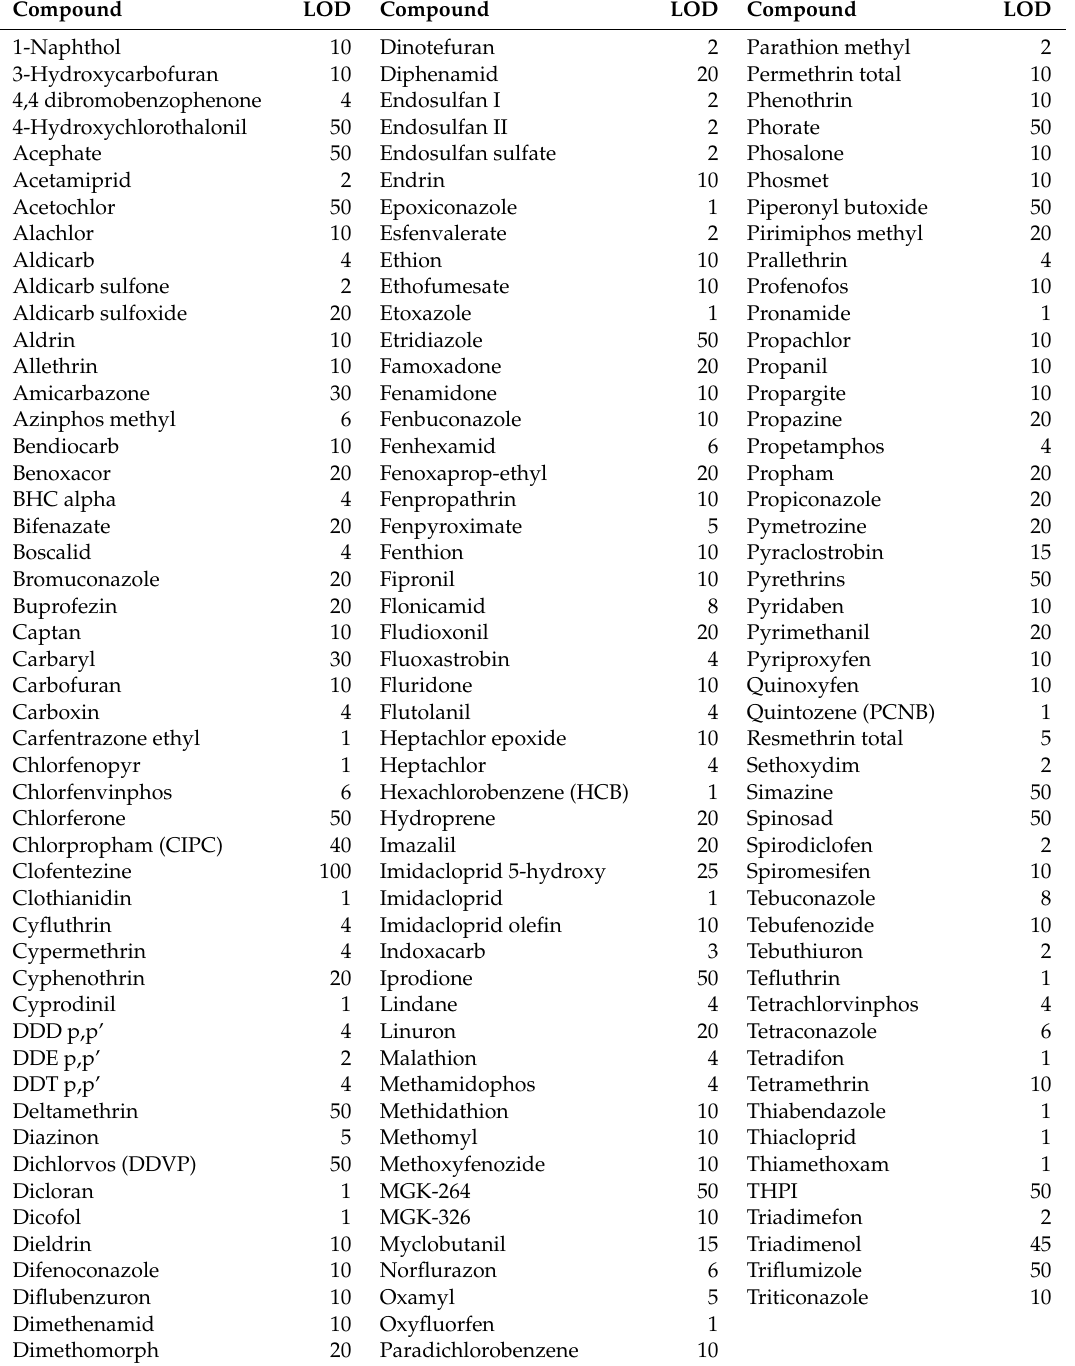
Table 6. All beehive samples were screened for 174 common agricultural chemicals and metabolites. Of these, 148 compounds that were not detected in any samples are listed, with their levels of detection (LOD) in